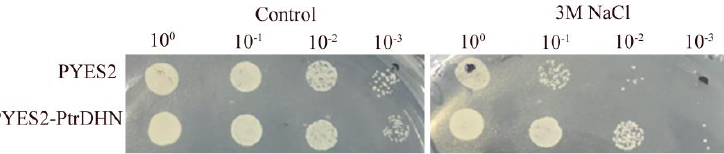
Figure 4. Analysis of salt tolerance in PtrDHN-3 -overexpressing and control (transformed with an empty pYES2 vector) yeast cells. Yeast cultures were grown in SC-ura liquid medium containing 2% ( w / v ) galactose for 1 d at 30 °C. Concentrations of PtrDHN-3 -overexpressing and control yeast cells were adjusted to the same level then identical numbers of cells were resuspended in 3 M NaCl for 2 d. Yeast clones diluted 0, 10, 100, and 1000 times were then spotted onto SC-ura agar plates and incubated at 30 °C for 3 d.